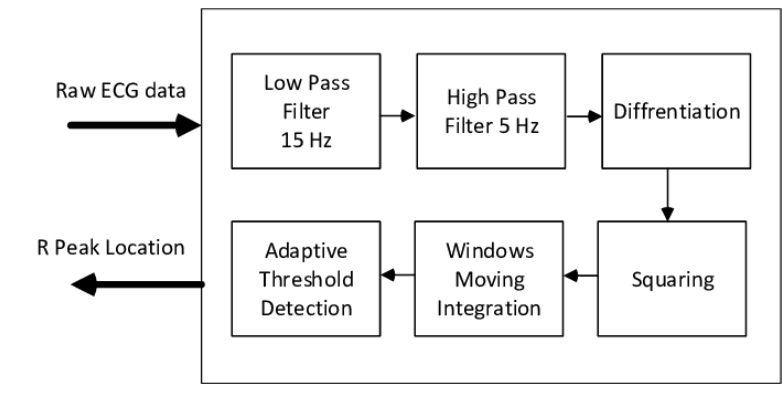
Figure 14. The Pan–Tompkins